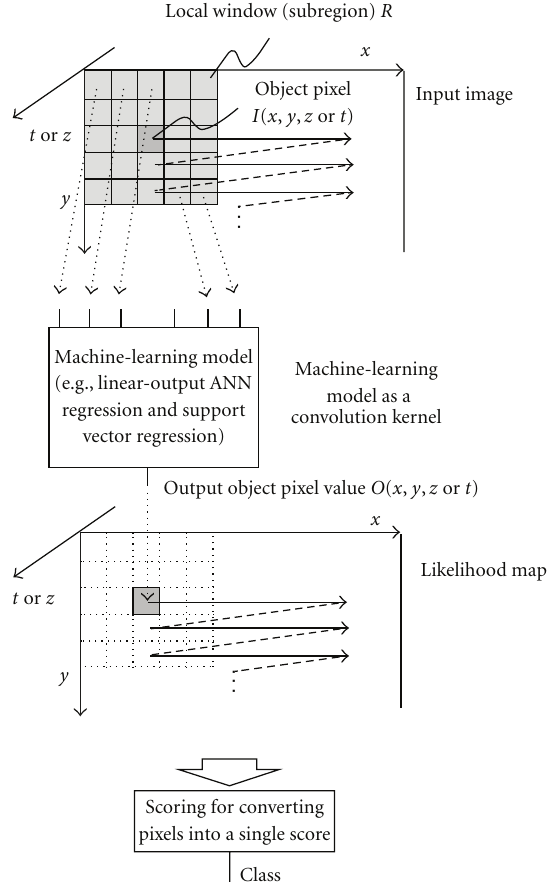
Figure 1: Generalized architecture of an MTANN (a class of PML) consisting of an ML model (e.g., linear-output ANN regression and support vector regression) with subregion input and single- pixel output. All pixel values in a subregion extracted from an input image are entered as input to the ML model. The ML model outputs a single pixel value for each subregion, the location of which corresponds to the center pixel in the subregion. Output pixel value is mapped back to the corresponding pixel in the output